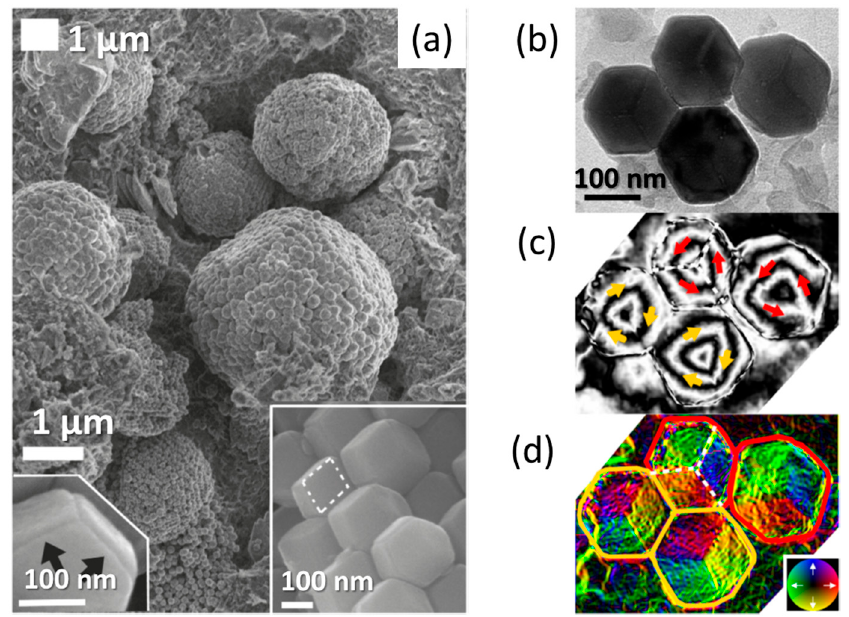
Figure 7. A short summary on the experimental observation of colloidal crystals (mesocrystals) of magnetite in the Tagish Lake meteorite. ( a ) SEM images of framboids built up by monodisperse magnetite rhombic–dodecahedraly shaped nanoparticles (bottom insets) arranged in a close-packed array with face-centered cubic ( fcc ) symmetry. ( b ) TEM image of individual magnetite nanoparticles, ( c – d ) reconstructed phase images obtained from the electron hologram show that each individual crystal has a vortex magnetic structure. ( d ) Color-coded magnetic induction map obtained from the gradient of the magnetic phase image. The color wheel indicates the direction of the magnetic induction. Figures are adapted from Ref. [49] with permission of Macmillan Publishers Limited.